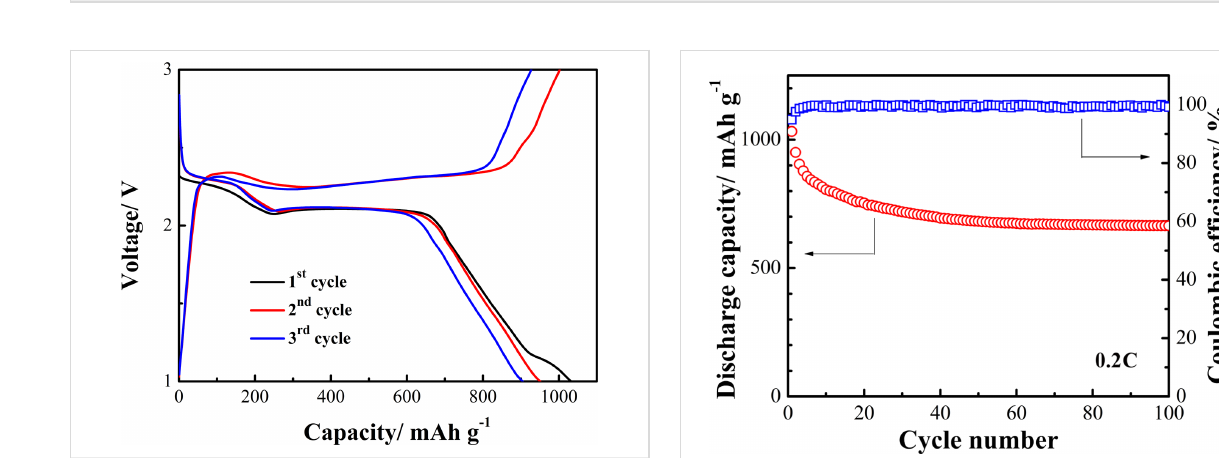
Figure 5: XPS spectra of S/ZnO@NCNT composite.